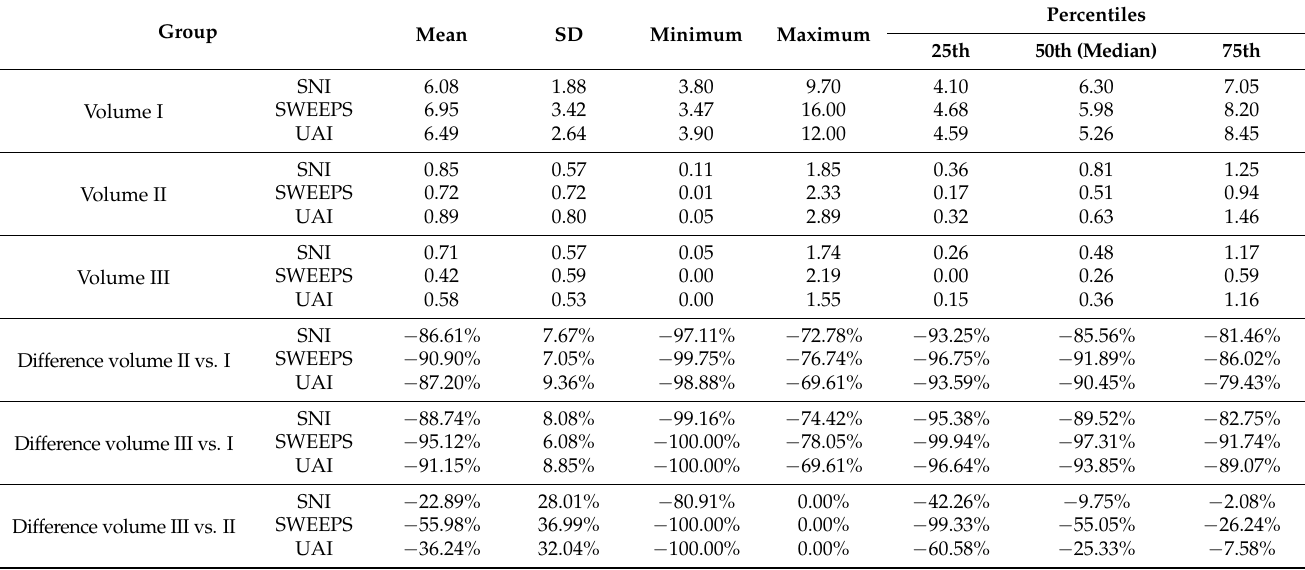
Table 1. Presentation of the volume (in mm 3 ) of the filling material initially (Volume I), after the retreatment (Volume II), and after final irrigation protocol (Volume III) and reduction rate (in %) of the volume of the filling material in each retreatment